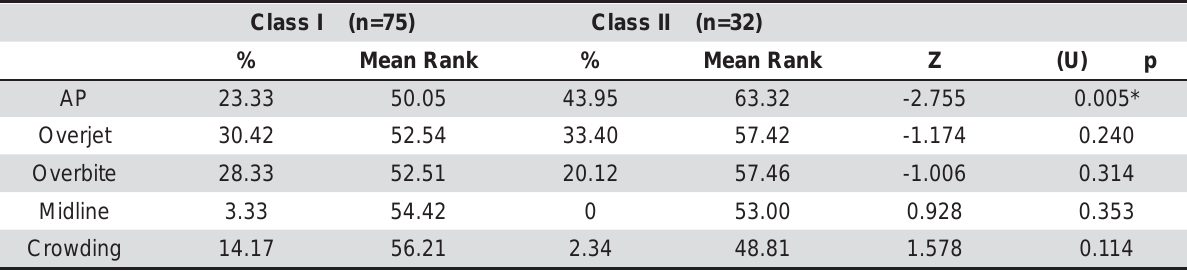
Table 3- Comparison of Class I and complete Class II malocclusion groups regarding F-PAR individual components, and proportion of each PAR component in